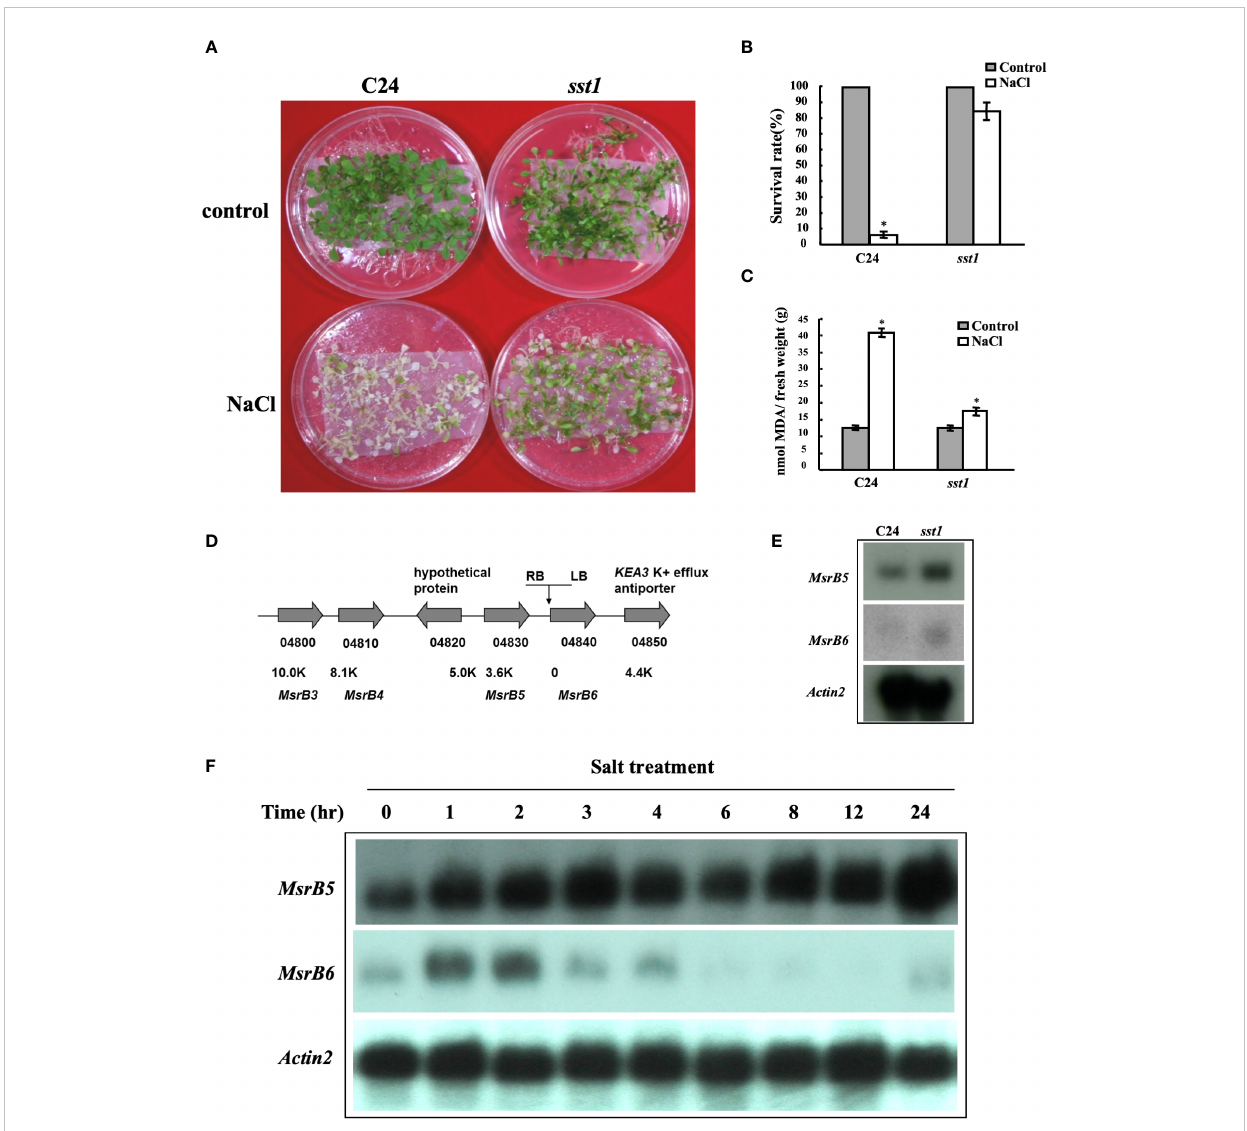
FIGURE 1 Arabidopsis salt-stress tolerance 1 ( sst1 ) mutant plants are tolerant to salt stress. (A) Wild-type (C24) and sst1 plants (T 2 ) were grown on 1/2 MS within mesh for 11 days and transferred to 1/2 MS medium containing 150 mM NaCl for 7 days. (B) Their survival rate was estimated. (C) Malondialdehyde (MDA) content was determined after salt treatment and plants were transferred back to ½MS medium for another 3 to 4 days. (D) Annotation of the fl anking region of the sst1 insertion site on chromosome 4. The activation-tagging T-DNA contains 4 copies of 35S enhancer in the right border (RB) as shown. Gene annotation and distance from the insertion site are indicated. (E) RNA gel blot analysis of wild-type C24 and sst1 mutant plants. Each lane contained 10 m g of total RNA. The membrane was probed with AtMSRB5 , AtMSRB6 and the internal control Actin 2 . (F) C24 in 1/2 MS medium was transferred to 150 mM NaCl medium and sampled at different times. Total RNA was extracted and analyzed for the expression level of AtMSRB5 and AtMSRB6 . Data are means ± SD (n = 20) of three independent experiments. *, P <